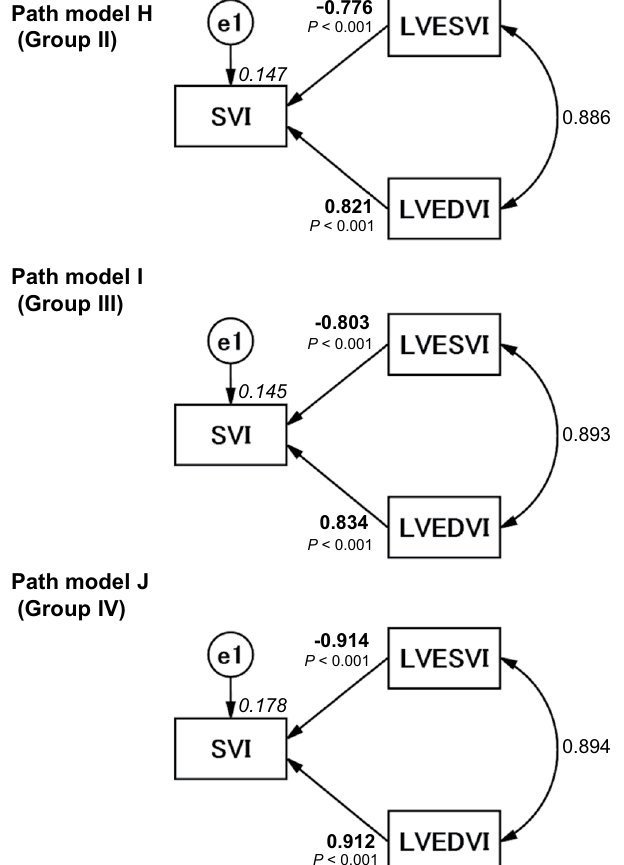
Figure 4. Path models H–J. The paths are displayed with coefficients that indicate the standardized coefficients of the regressing independent variable on the dependent variable of the relevant path in the subtype group (path models H–J, LVESVI and/or LVEDVI to SVI), i.e., Groups II (path model H), III (path model I) and IV (path model J). These variables are the standardized regression coefficients (direct effect), squared multiple correlations [on the upper right side of rectangles (in italics)] and correlations between each of the variables. Other variables included in the covariance structure analysis are shown in Supplemental Tables 9, 10, and 11. LVESVI, left ventricular end-systolic volume index; LVEDVI, left ventricular end-diastolic volume index; SVI, systolic volume index; and e, extraneous